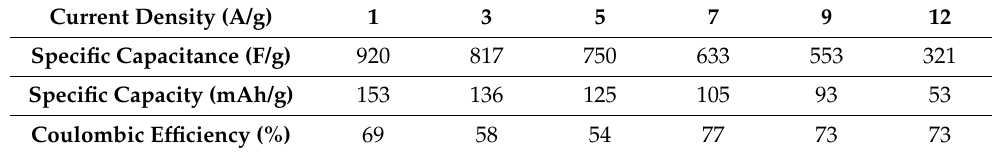
Table 1. The current discharge rates and the capacitance values of the CuSe-TiO 2 -GO nanocomposite. Current Density (A/g) 1 3 Specific Capacitance (F/g) 920 Specific Capacity (mAh/g) 153 Coulombic Efficiency